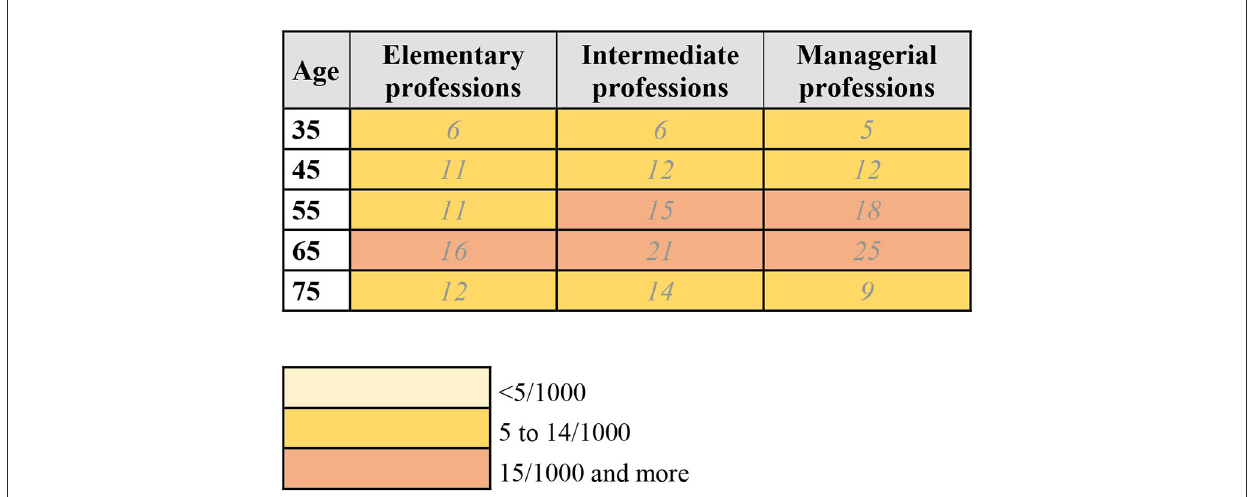
FIGURE3 10-year risk chart of breast cancer for women by occupational group. The chart indicates the number of women per 1,000 who will get breast cancer during the next 10 years, beginning at the indicated age. Elementary professions: agriculture, industry, crafts, elementary professions. Intermediate professions: intermediate professions, administrative employees, personal service and personnel. Managerial professions: managerial, intellectual, or scientific